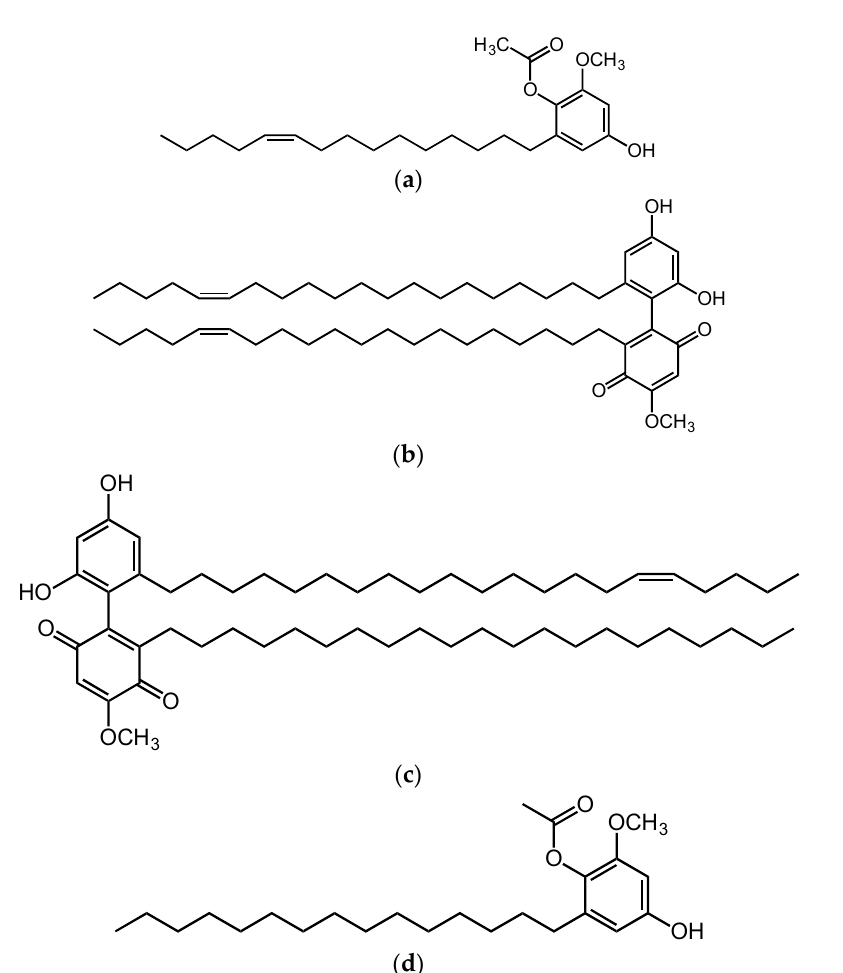
Figure 5. Chemical structure of cytotoxic alkylresorcinols from M. pumilum . 1- O -methyl-6-acetoxy- 5-(pentadec-10 Z -enyl)resorcinol ( a ), labisiaquinone A ( b ), labisiaquinone B ( c ), and 1- O -methyl-6- acetoxy-5-pentadecylresorcinol ( d ).